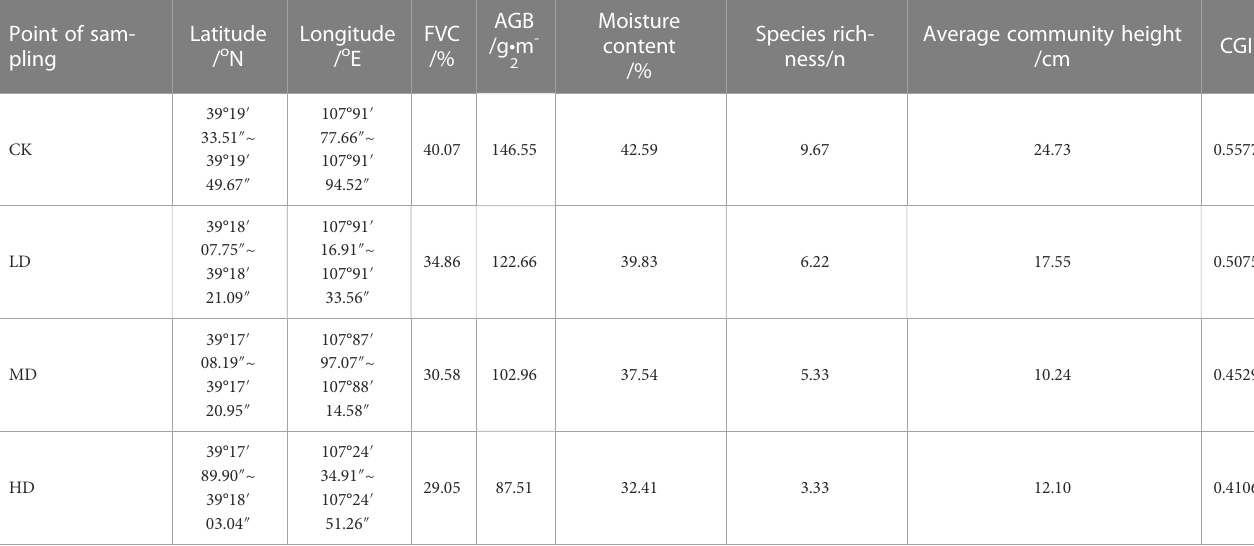
TABLE 1 Community characteristics of experimental